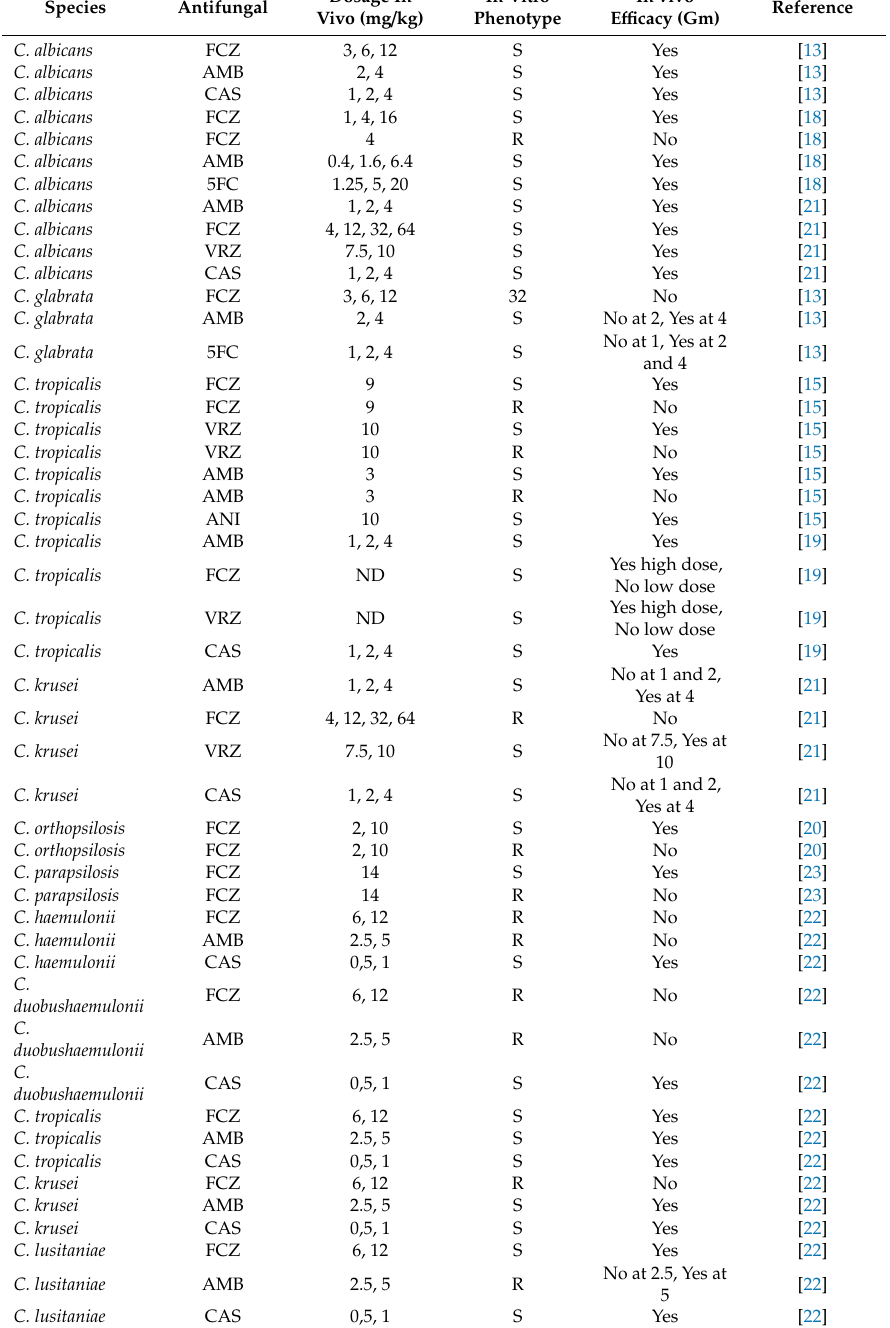
Table 1. Evaluation of licensed antifungals e ffi cacy against Candida spp. in G. mellonella